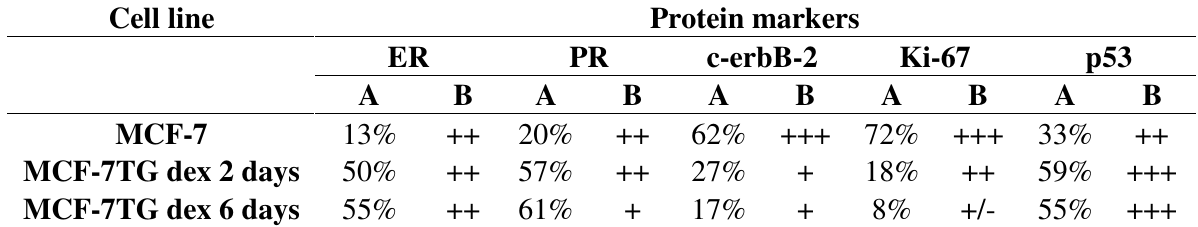
Table 1. Percentages of stained cells and intensities of staining, obtained by microscopic study of control and gef gene-induced cells treated with dexamethasone (1 mM) for 2 or 6